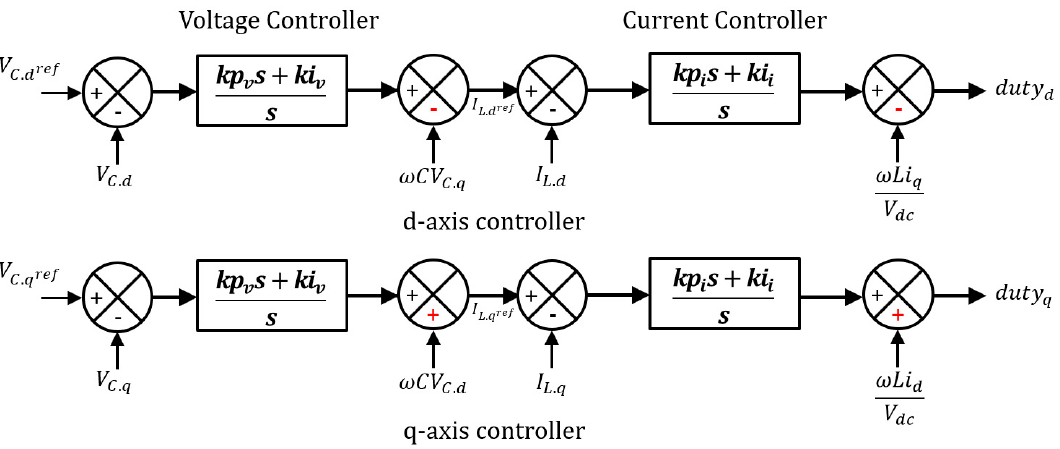
Figure 5. Two-loop controller of a microgrid inverter.